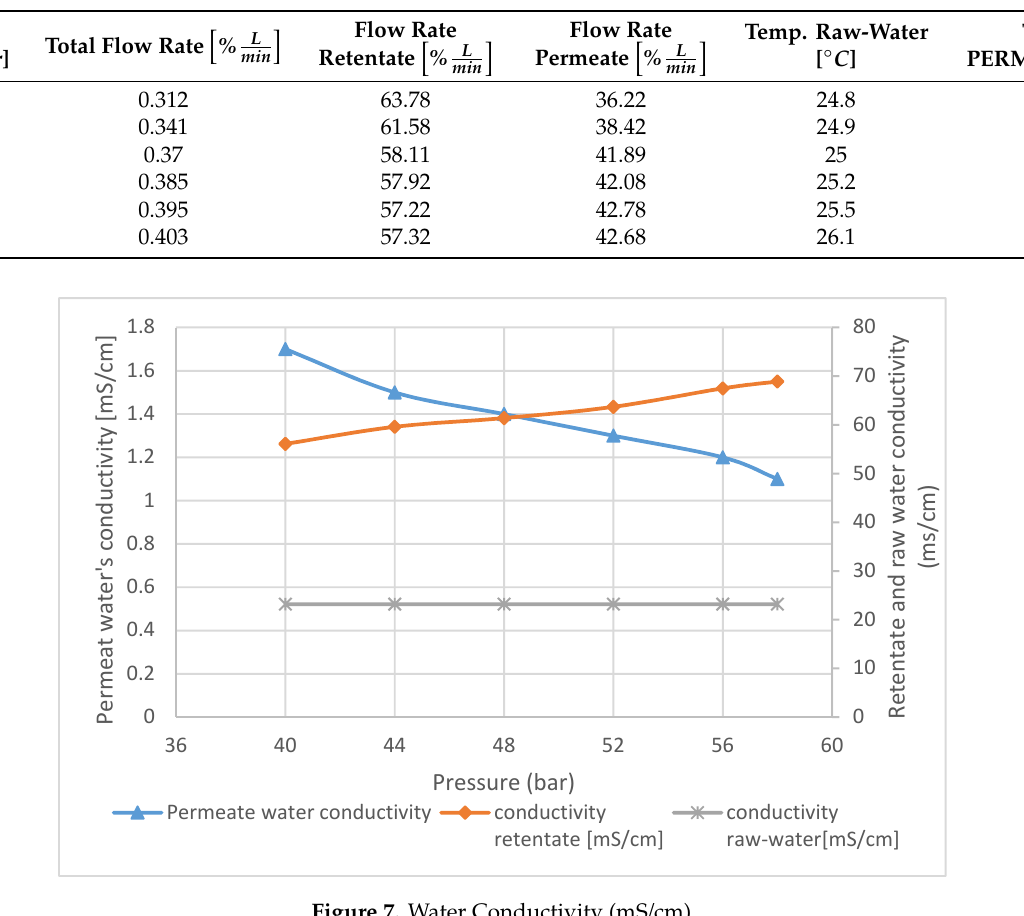
Table 2. Flow rate and temperature of the experimental trials.